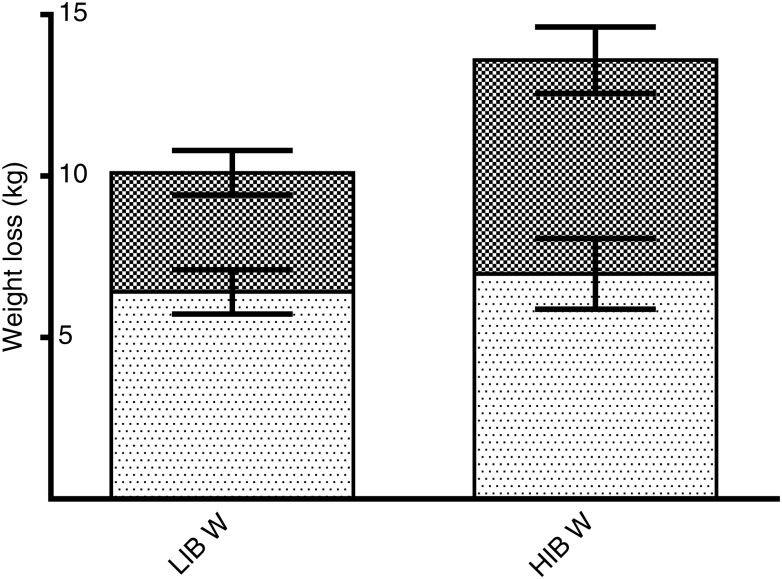
Fat-free mass (▒) and fat mass (░) loss in patients with higher initial body weight (HIBW; above the 50th percentile corresponding to body weight ≥135 kg) and patients with lower initial body weight (LIBW; below the 50th percentile corresponding to body weight <135 kg). Values are means, with standard errors represented by vertical bars. A mixed linear model was used to test for differences between the groups. There was a significant difference between the LIBW and HIBW groups.